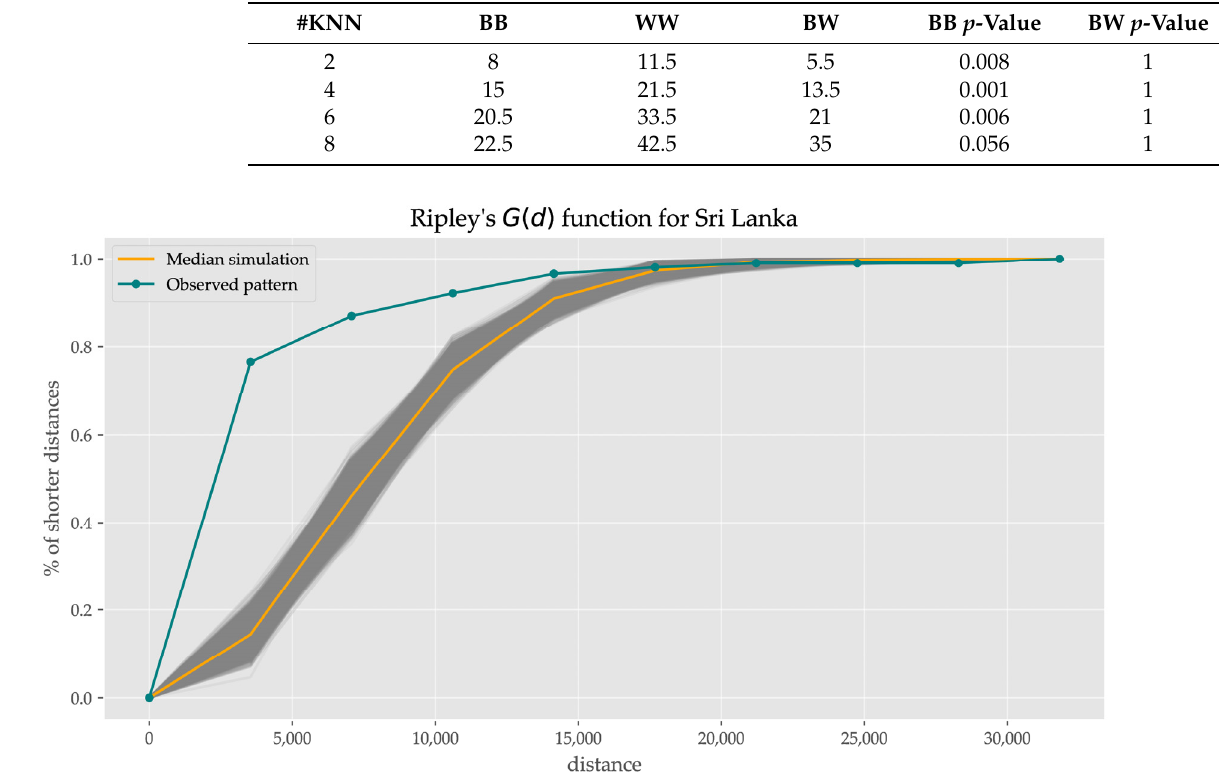
Figure 22. Ripley’s G(d) function for Sri